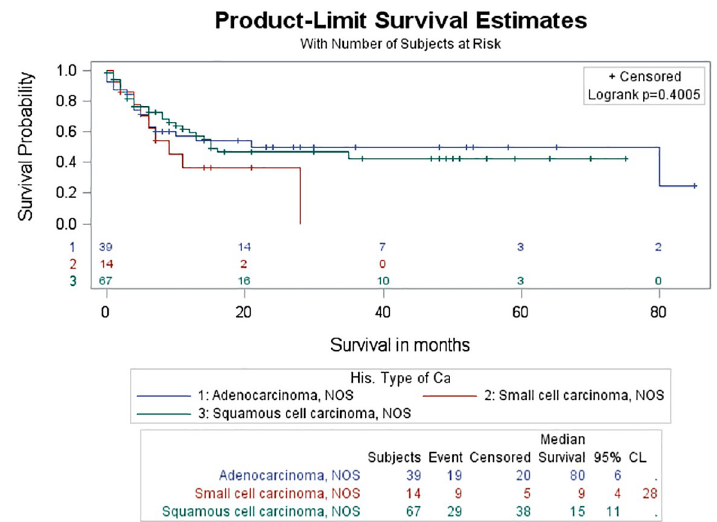
Fig 6. Survival curves between different types of lung cancer in the study group. There was no significant difference in survival rate between different types of lung cancer in the study group (log rank test, p = 0.4005).